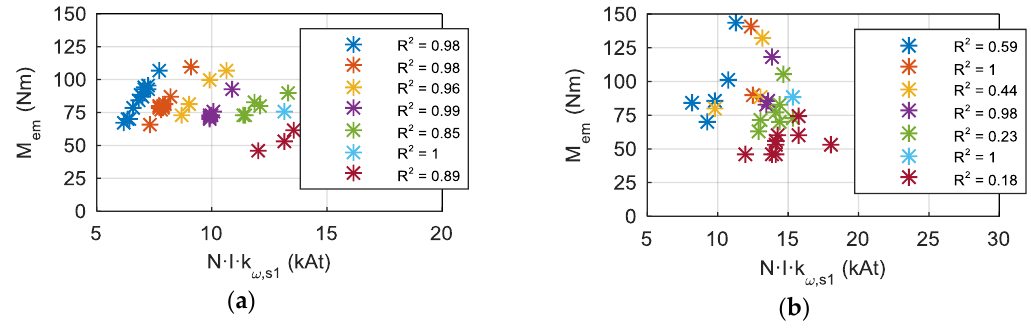
Figure 12. Mean electromagnetic torque ( M em ) versus the magnetomotive force multiplied by the first harmonic winding factor ( N·I·k ω,s 1 ) for ( a ) ISDW and FSDW machines; ( b ) FSCW machines.